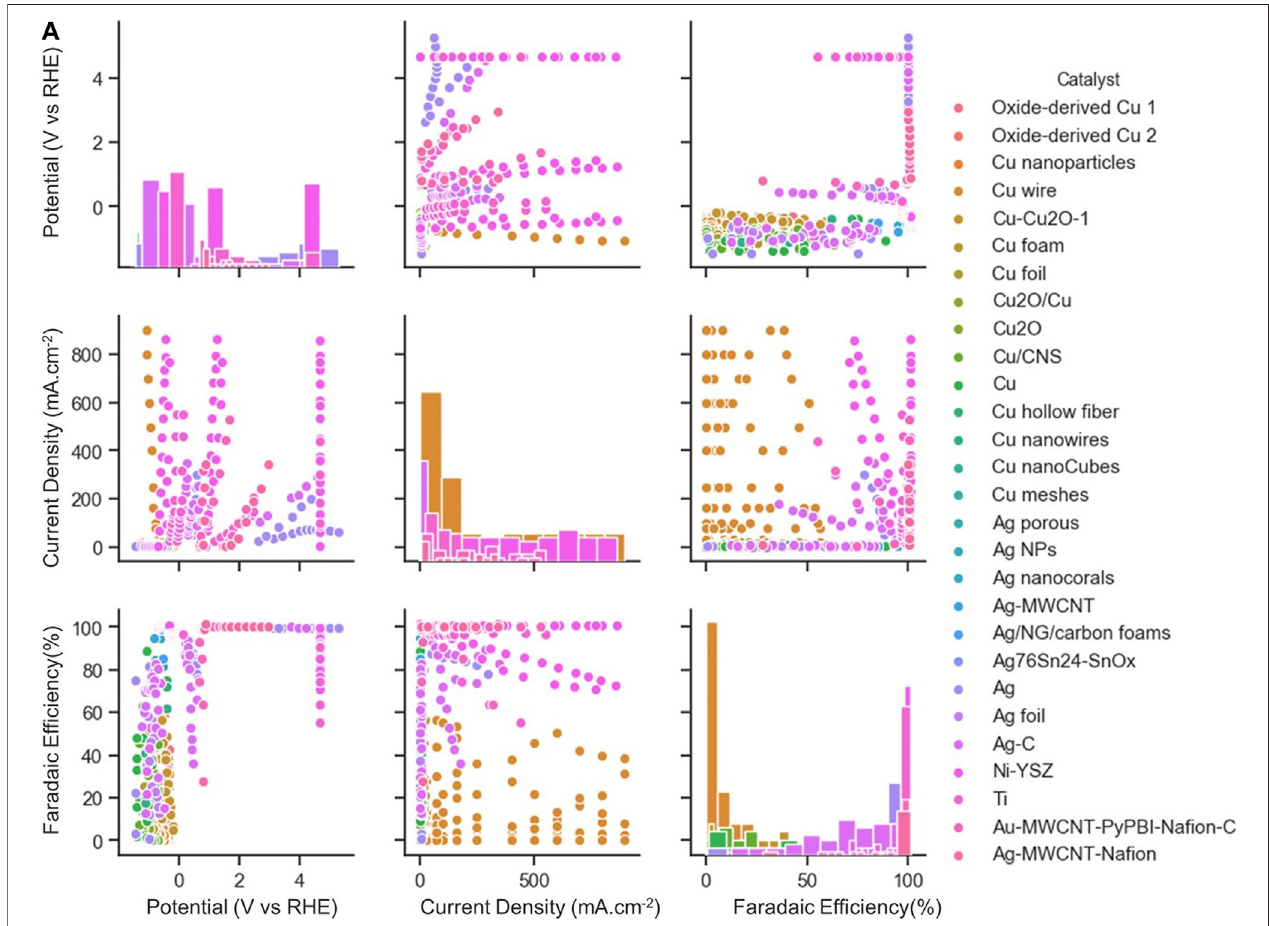
FIGURE 3 | Scatter plot matrix showing the data distribution for (A) both High-T and low-T (B) High-T, (C) Low-T of CO 2 RR according to three performance metrics. The elements in the diagonal (upper left to lower right) represent the respected range of data points for each catalyst type.